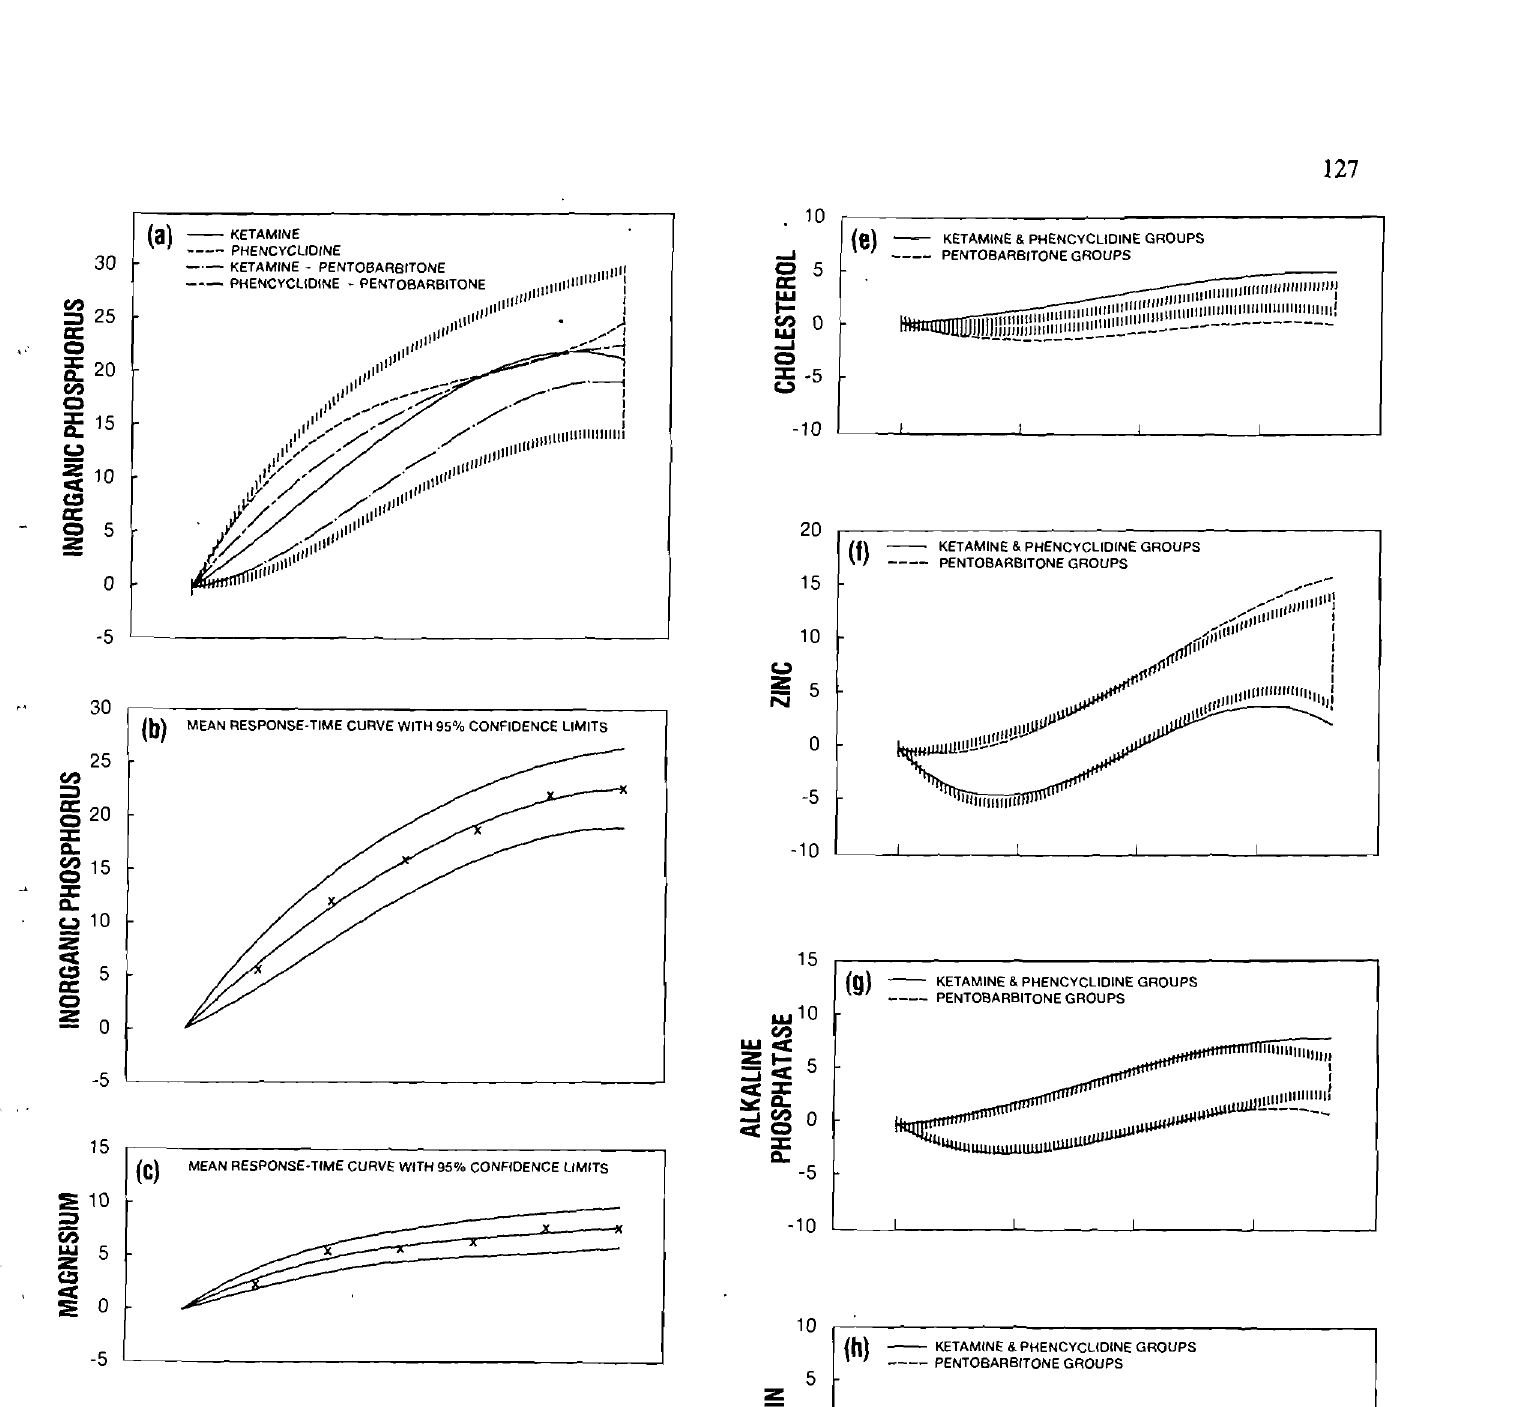
Fig. 1: Percentage change over time 0 in plasma levels of: (a) and (b) inorganic phosphorus (mean initial value: 1,66 mmol/t'l; (c) magnesium (0,74 mmol/f); (d) and (e) total cholesterol (2,86 mmol/t'l; (f) zinc (15,3 ",mol/t'l; (9) alkaline phosphatase (191 i.u./f); (h) total protein (72 g/f) and Ii) calcium (2,38 mmol/f). Results have been plotted for 4 groups of baboons either in dividually (a, d, il or pooled into 2 groups (e-h) and plotted ("""""'111), with a 95% critical range or pooled into one group (b,c) and plotted with simultaneous 95% confidence